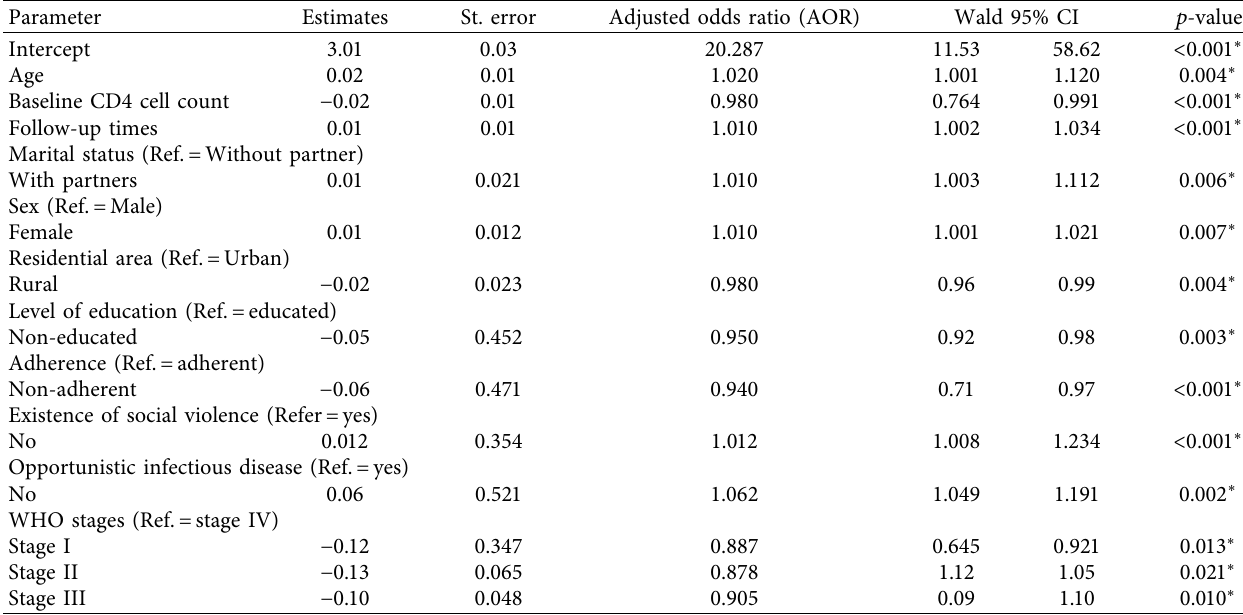
Table 2: Parameter estimates for disclosure of HIV status for sexual